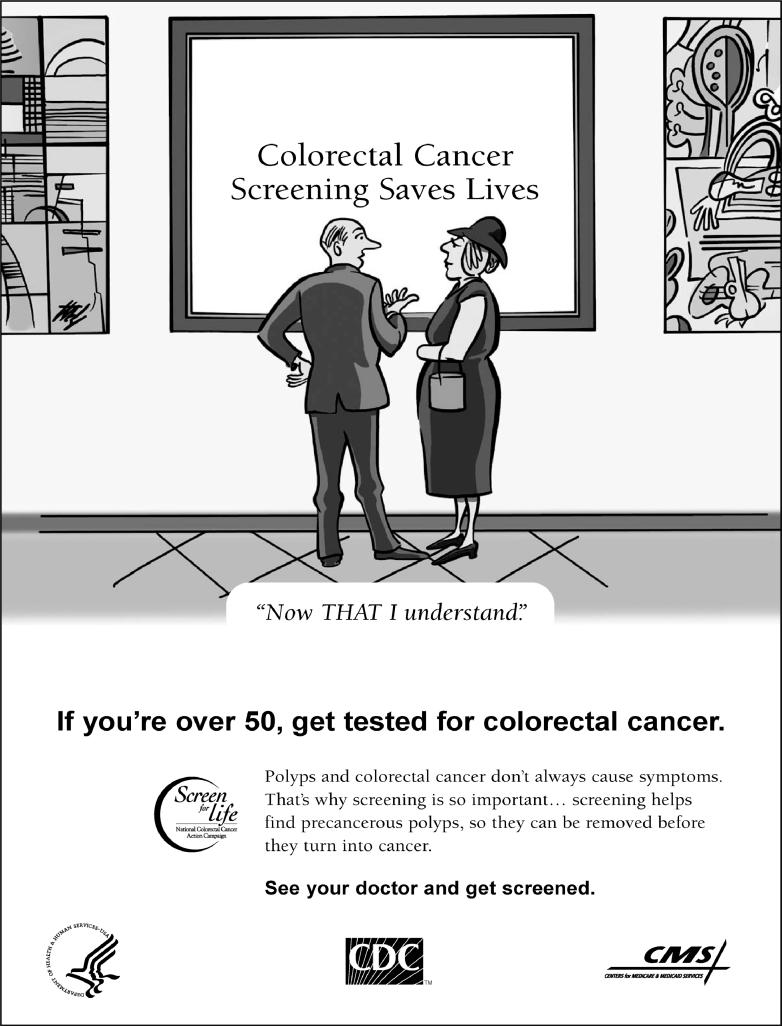
In the US, the CDC (Centers for Disease Control and Prevention) is promoting CRC screening for people over 50 years old